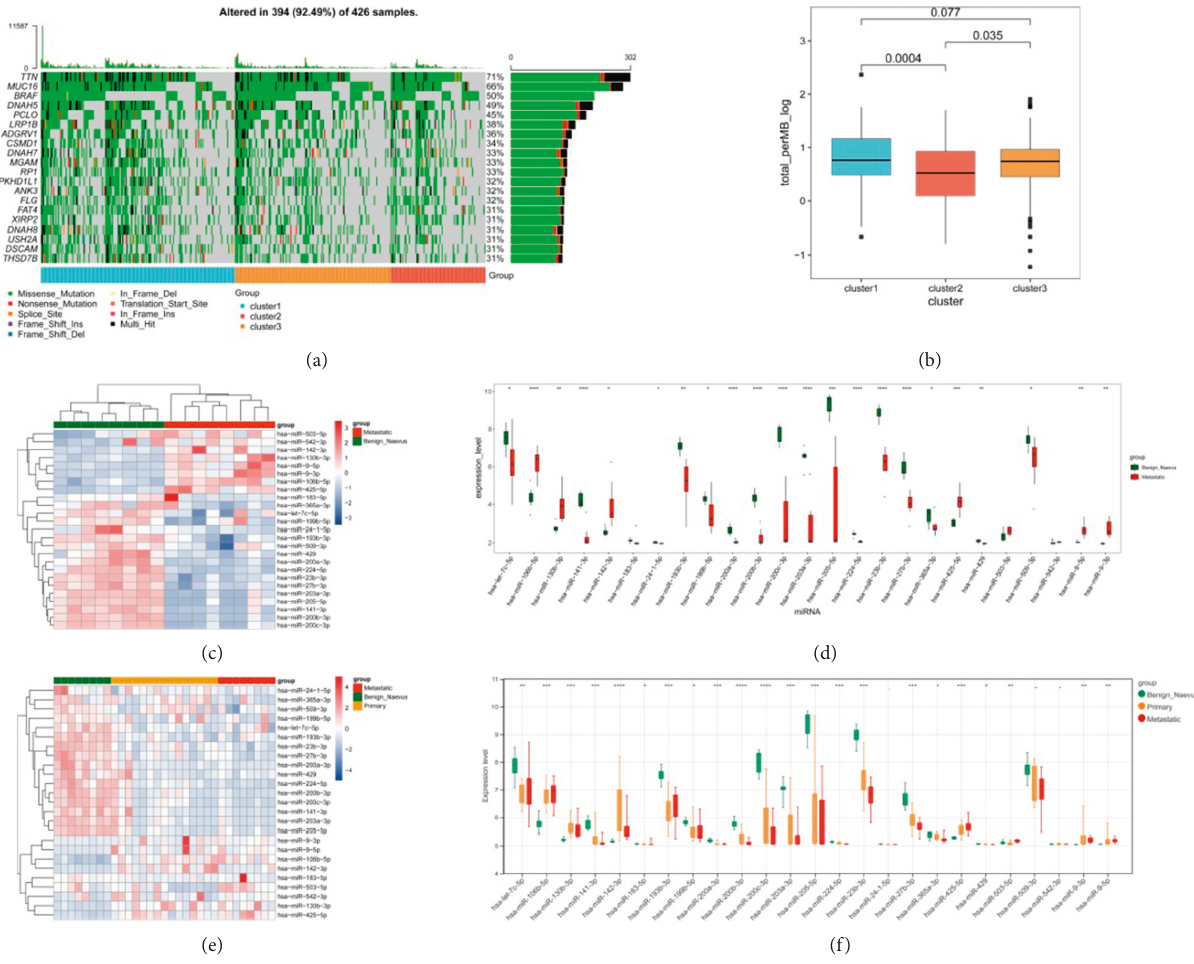
Figure 8: Tumor mutation burden (TMB) analysis and validation analysis. (a) The waterfall plot of the top 20 genes with the highest mutation frequency in each subtype. (b) the TMB value in subtypes. The heatmap (c) and box diagram (d) of 25 miRNAs between samples from benign and metastatic groups in the GSE18509 dataset. The heatmap (e) and box diagram (f) of 25 miRNAs between samples from benign and metastatic groups in the GSE24996 dataset. ∗ P < 0 .